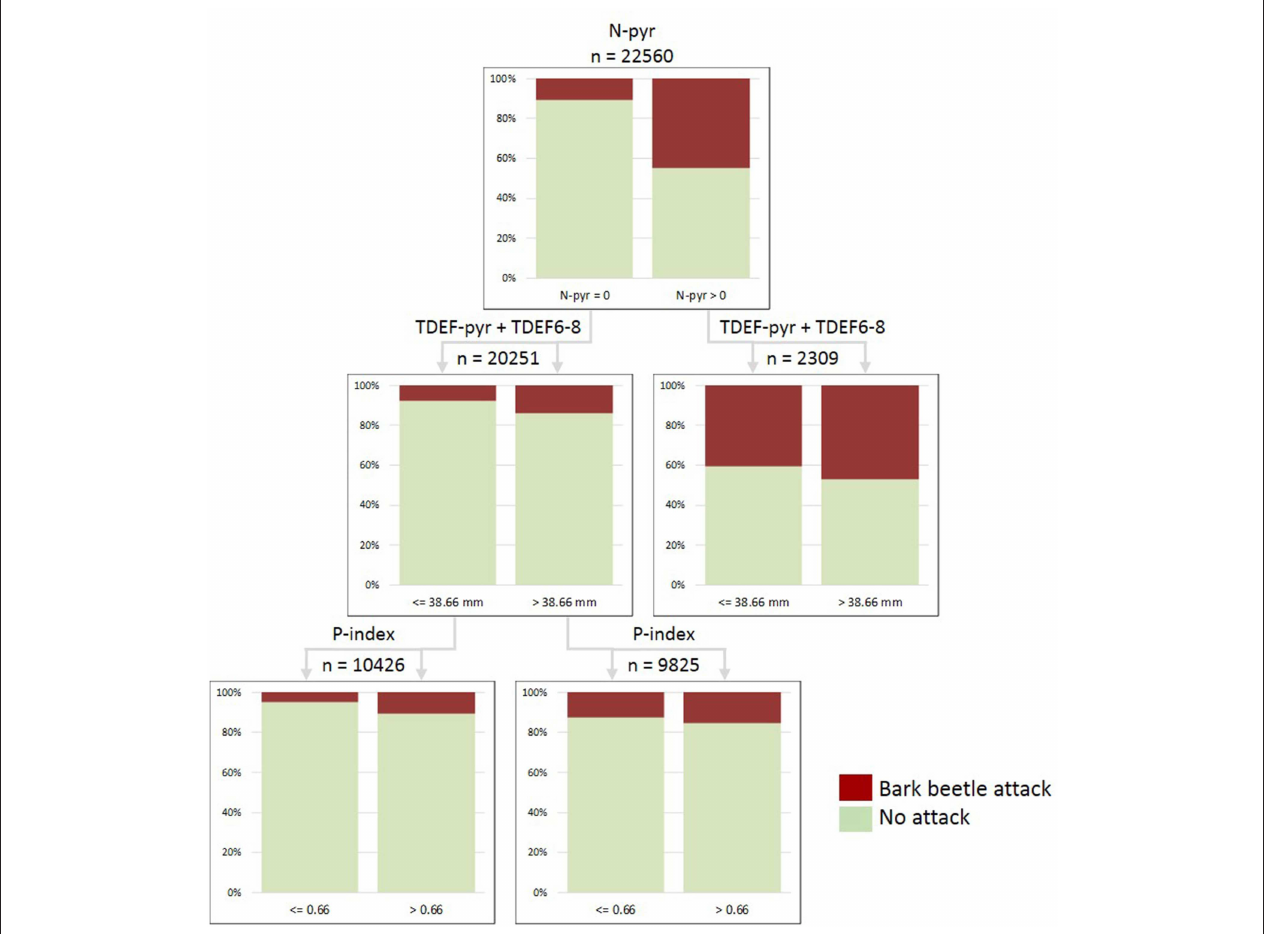
FIGURE 6 | Classification tree “Waldviertel-Voralpen” (WV) built for the period 2014–2016 and including the variables: salvage loggings in the previous year (N-pyr), transpiration deficits accumulated in the previous year and June to August of the actual season (TDEF-pyr + TDEF6-8), and stand predisposition index (P-index). Total number of examined stands x observation years = 22,560; proportions of correct predictions: 84.7% in total, 32.2% presence, 93.4% absence of